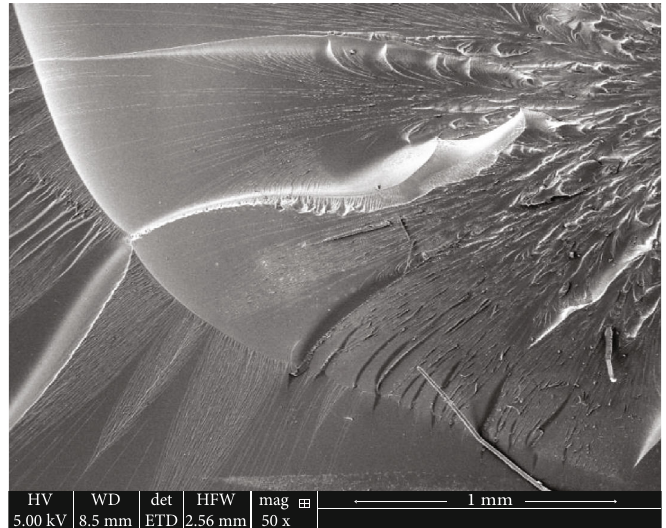
Figure 13: Fracture surfaces due to tensile failure in epoxy subjected to 1500 thermal cycles.